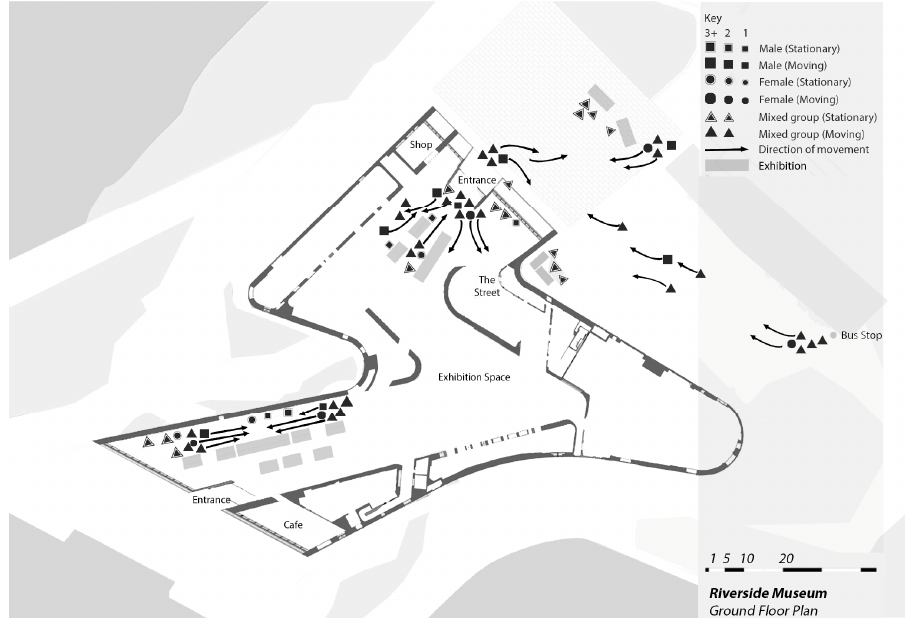
Figure 9. A representative navigational map on midday Saturdays at the Riverside Museum. (Floorplan by L. MacLean based on figure by ZHA published in ArchDaily, annotations by A. Salama and L. MacLean)